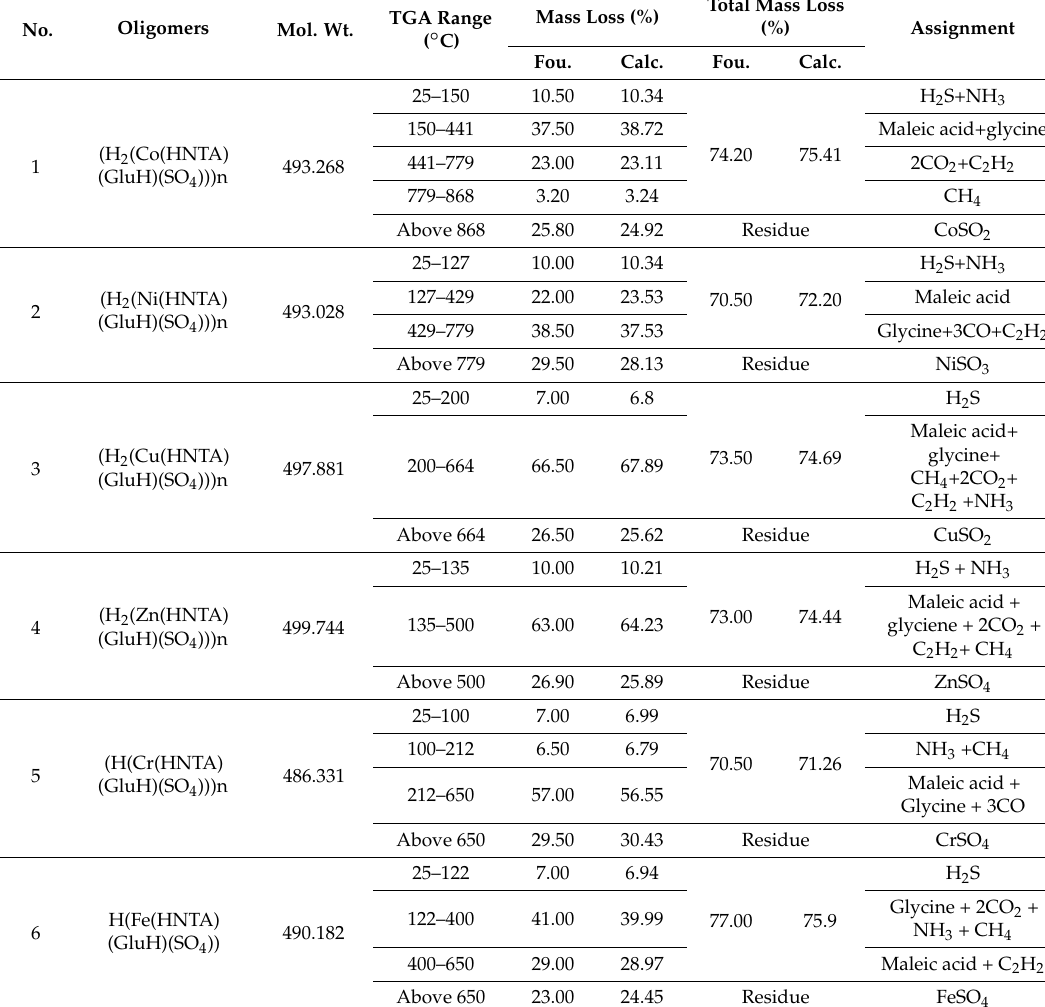
Table 4. The values for the decomposition along with the species lost in each